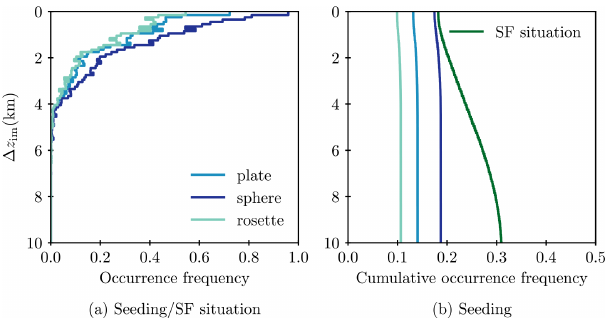
Figure 6. (a) Seeding cases per seeder–feeder situation. (b) Cumu- lative occurrence frequency of possible seeder–feeder situations (SF situation, green) and successful seeding assuming plate-like spher- ical and bullet rosette ice crystals. Note that (cid:49)z im = 0m is at the base of the lowest cirrus cloud layer with T < − 35 ◦